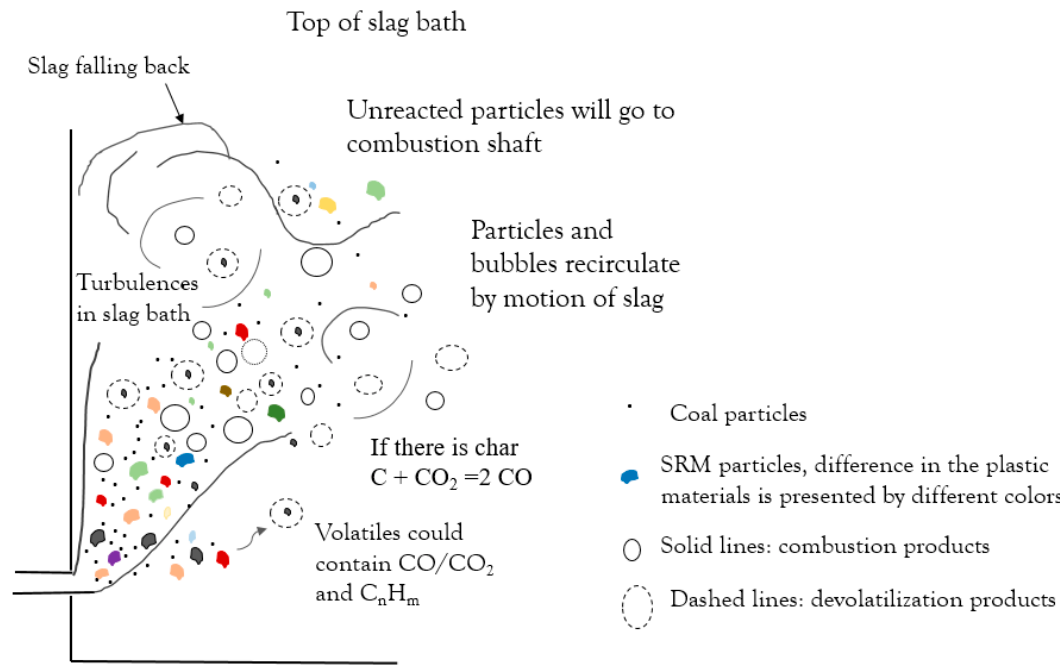
Figure 9. Schematic illustration of possible phenomena by injection of SRM in a fuming furnace.